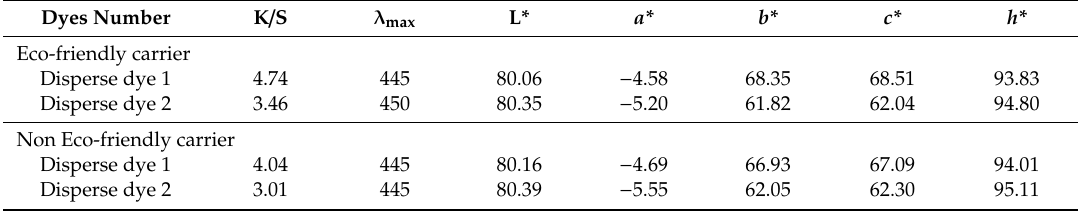
Table 1. Optical measurements of the disperse dyes on polyester fabrics.